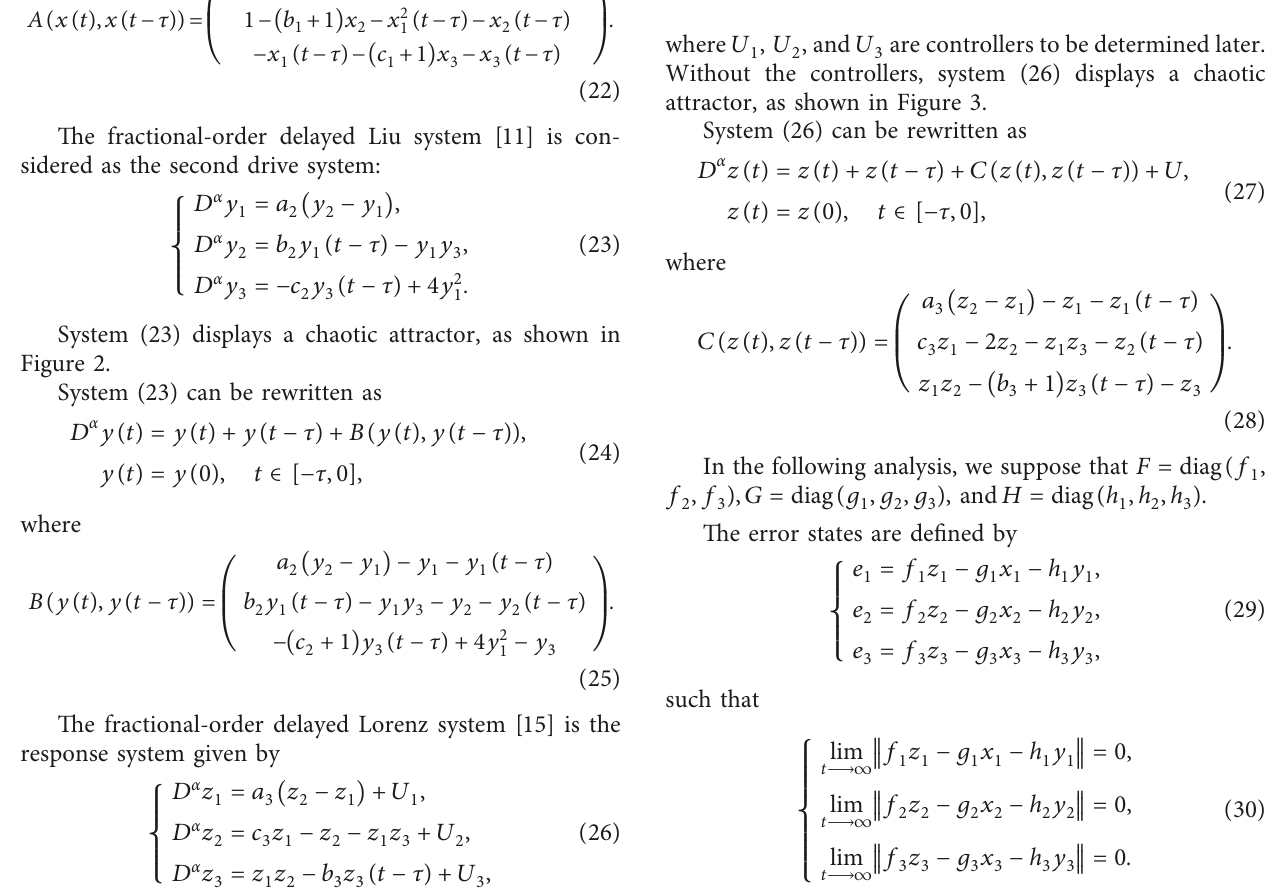
Figure 2: Chaotic attractor of Liu system: α � 0 . 92 , τ � 0 .